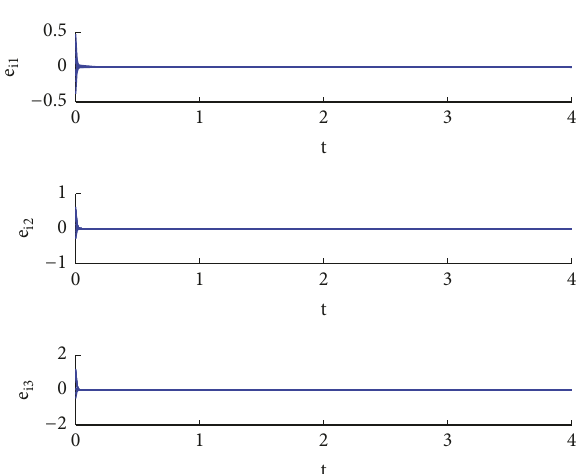
Figure 3: Finite-time mixed interlayer synchronization errors 𝑒